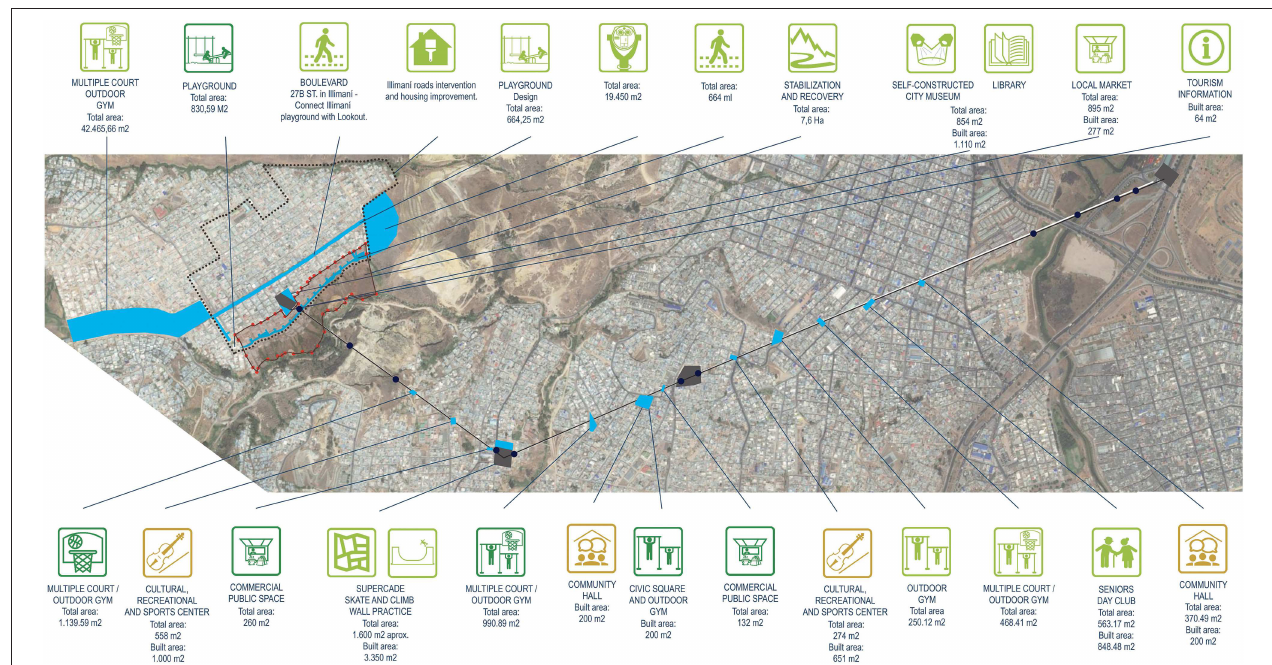
FIGURE 1 | Location of programs and infrastructure projects of TransMiCable. Source: Infographic from the city of Bogotá Planning Department. Reprint with permission from Martín Anzellini García-Reyes, an officer of the Bogotá Planning Department.